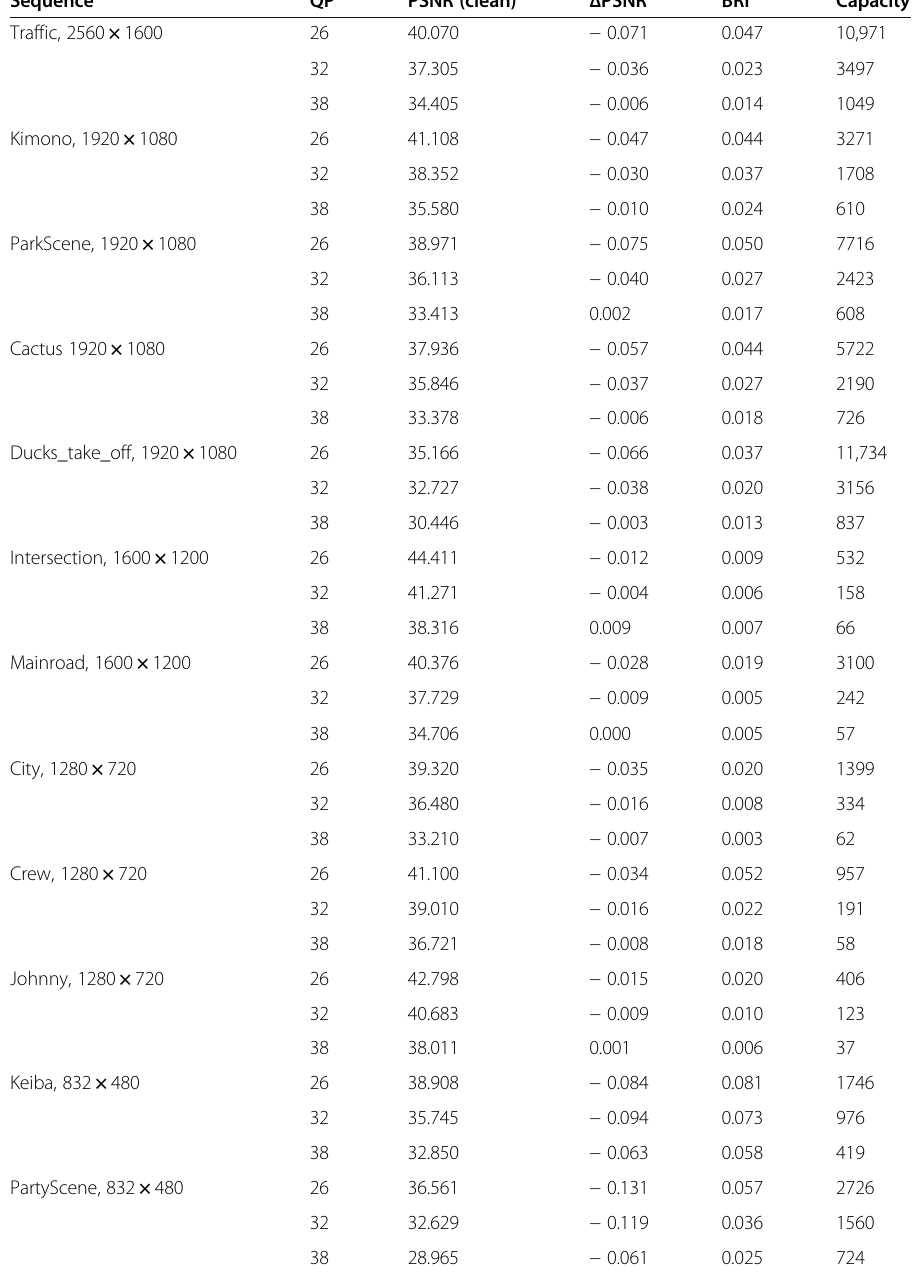
Table 12 The Δ PSNR, capacity, and BRI of the proposed algorithm with different QPs Sequence QP PSNR (clean) Δ